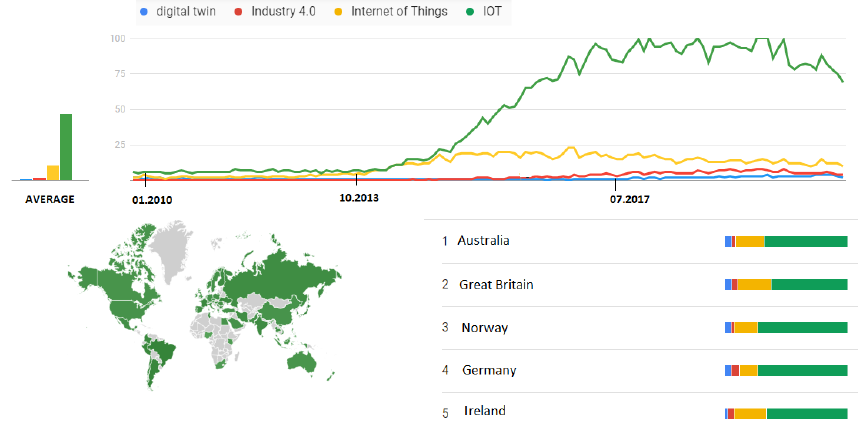
Figure 7. Trends in interest in the terms “Industry 4.0” (red line), “digital twin” (blue line), “Internet of Things” (yellow line), and “IoT” (green line) (concerns the period 1 Jan 2010–12 Jan 2021).